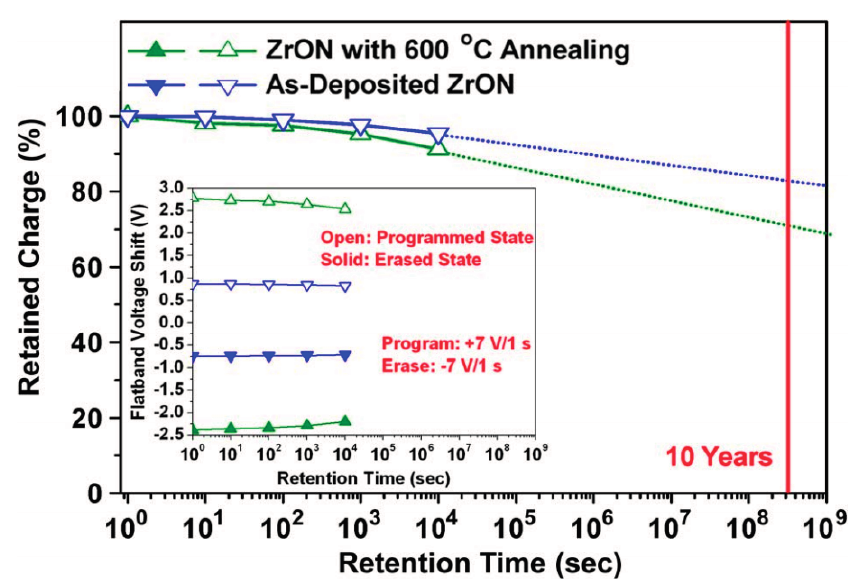
Figure 4. Retention characteristics at 85 °C represented by normalized retained charge for the programmed state of the memory with as-deposited and annealed ZrON films. Reused with permission from [37], Copyright 2010,